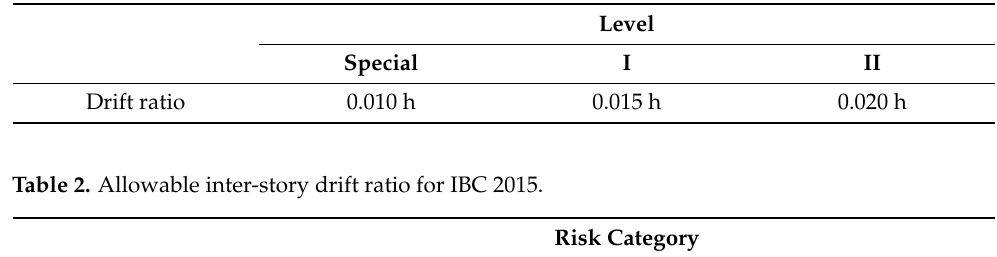
Table 1. Allowable inter-story drift ratio for KBC 2016.